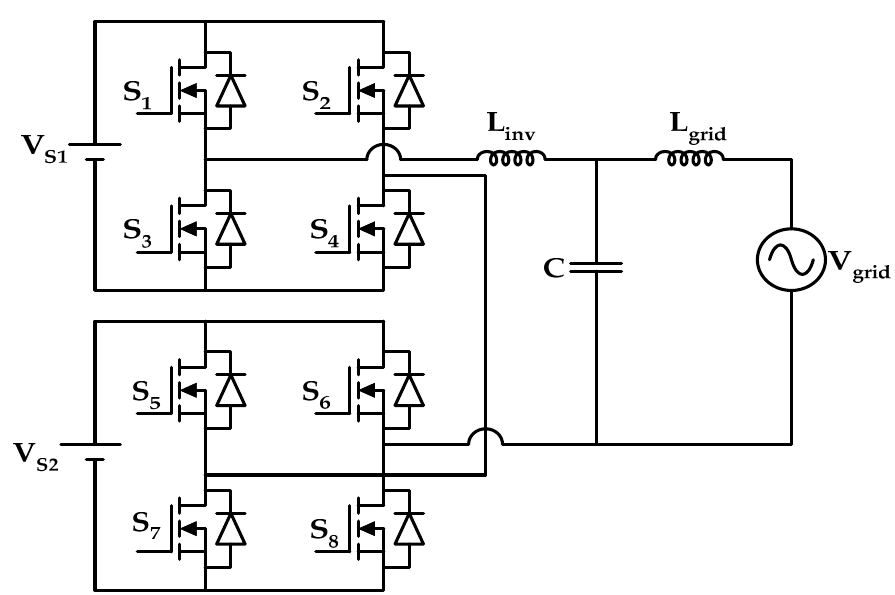
Figure 1. Five-level Cascaded H-Bridge (CHB) inverter with LCL filter connected to grid.